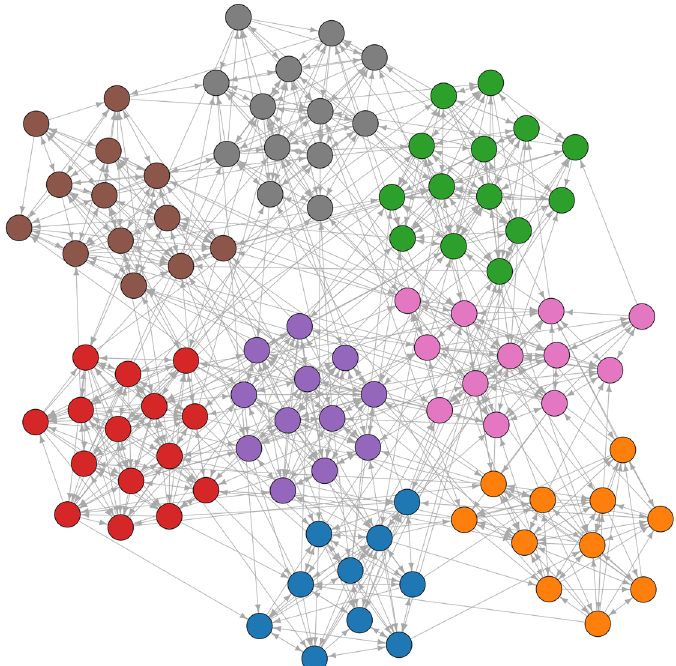
Fig 1. Force directed layout (Fruchterman-Reingold algorithm) of an example ground truth network of dimension D = 100.